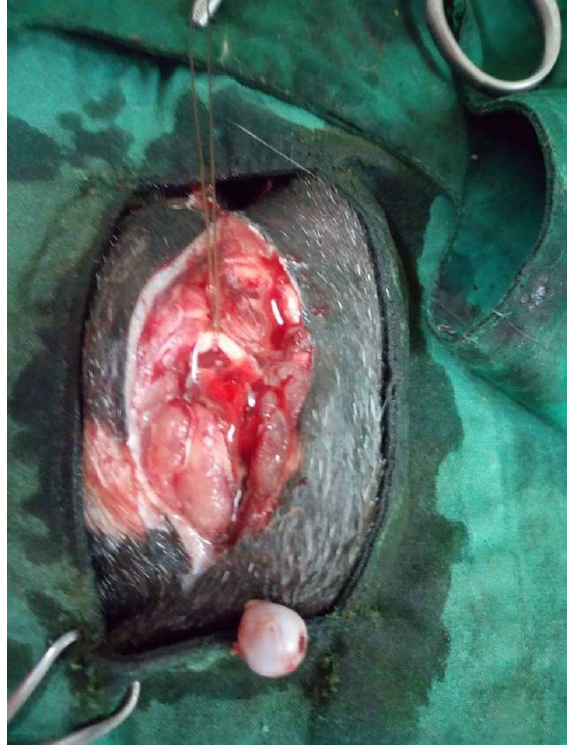
Figure 5. Femoral head resection (case 1) Case 2. Ten years old cat (3.5 kg) had accident by car 30 days ago. He showed both pelvic limbs ataxia, and urinary continent signs. The radiography revealed fracture, and luxation of S3, and Cd1 (Fig 6). Dorsal laminectomy was performed by removing S1-S3 of sacrum lamina, and tail removing at the first caudal vertebrae (Fig 7). Amoxycillin Figure 3. Radiography showed right dorsolateral hip joint plus clavulanic acid, and tofenamic acid were injected in- luxation (case 1) tramuscular for four days